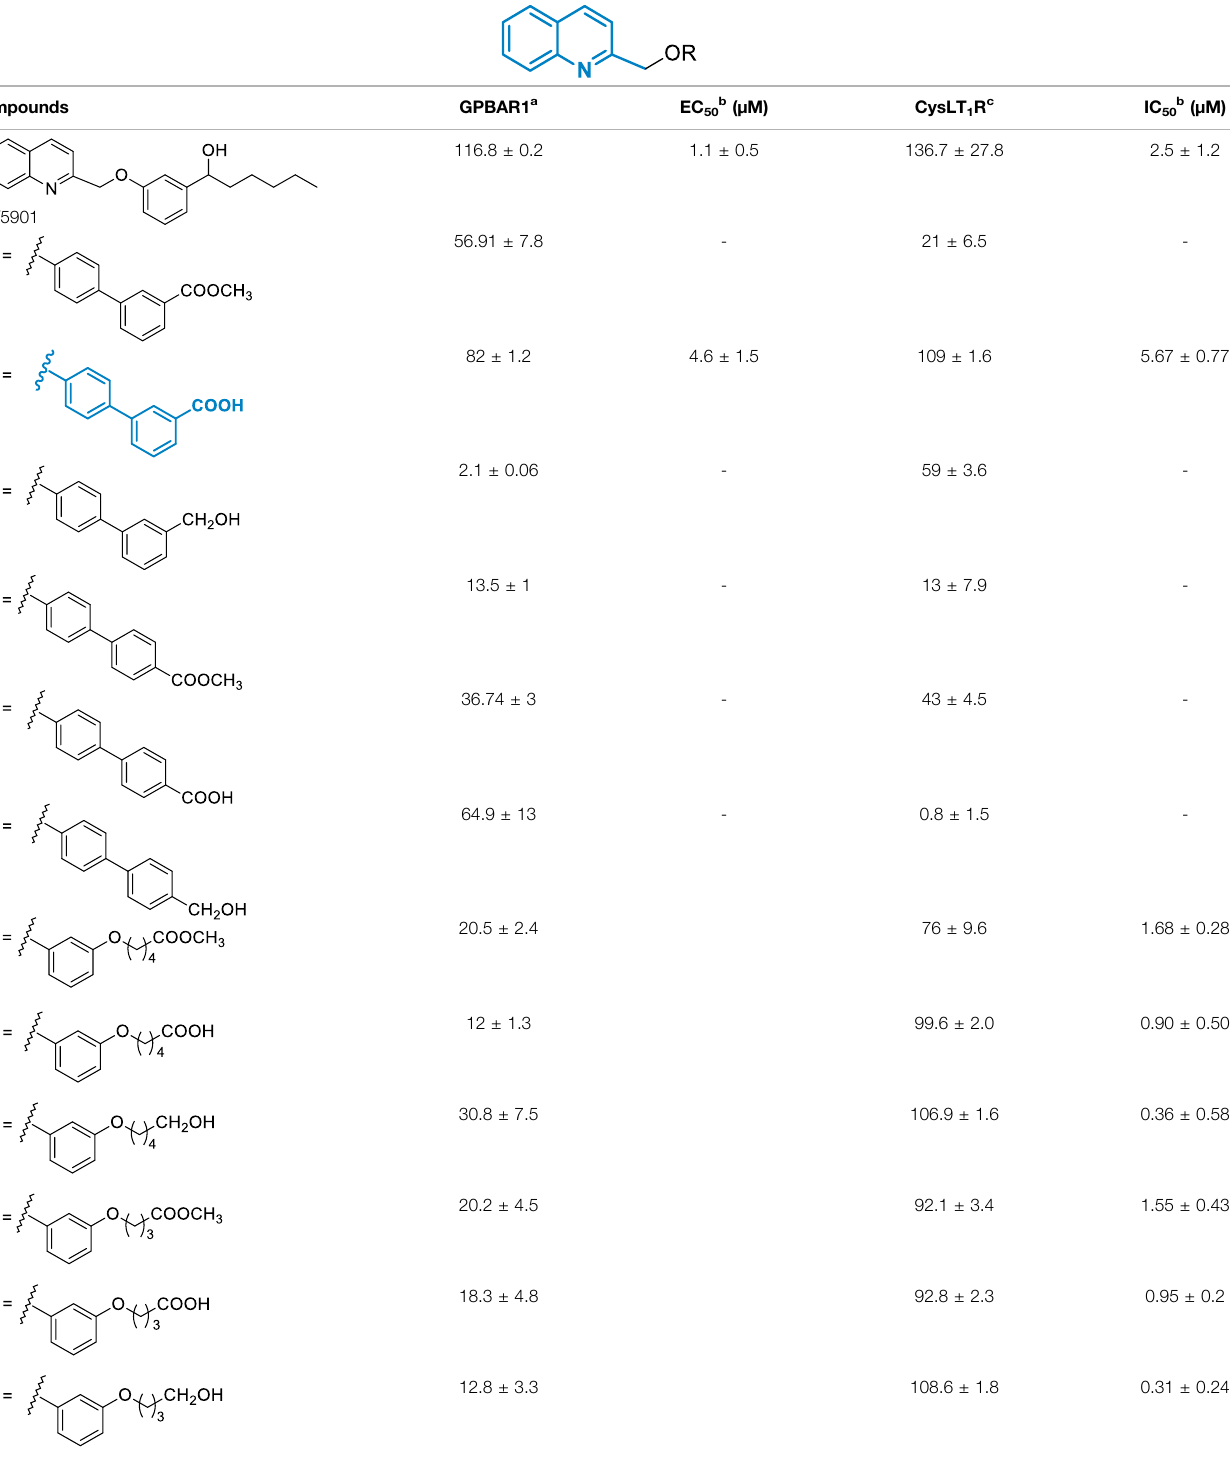
TABLE 1 | In vitro evaluation of compounds 1 –